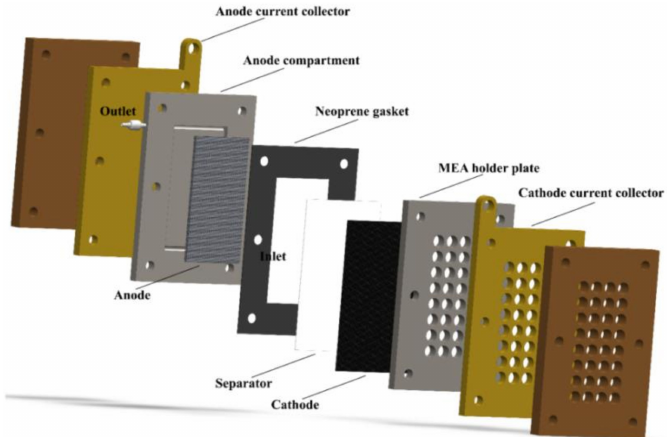
Figure 1. Exploded view of fuel cell components in an air-breathing configuration. Reproduced from reference [93] under CC BY 4.0 license.